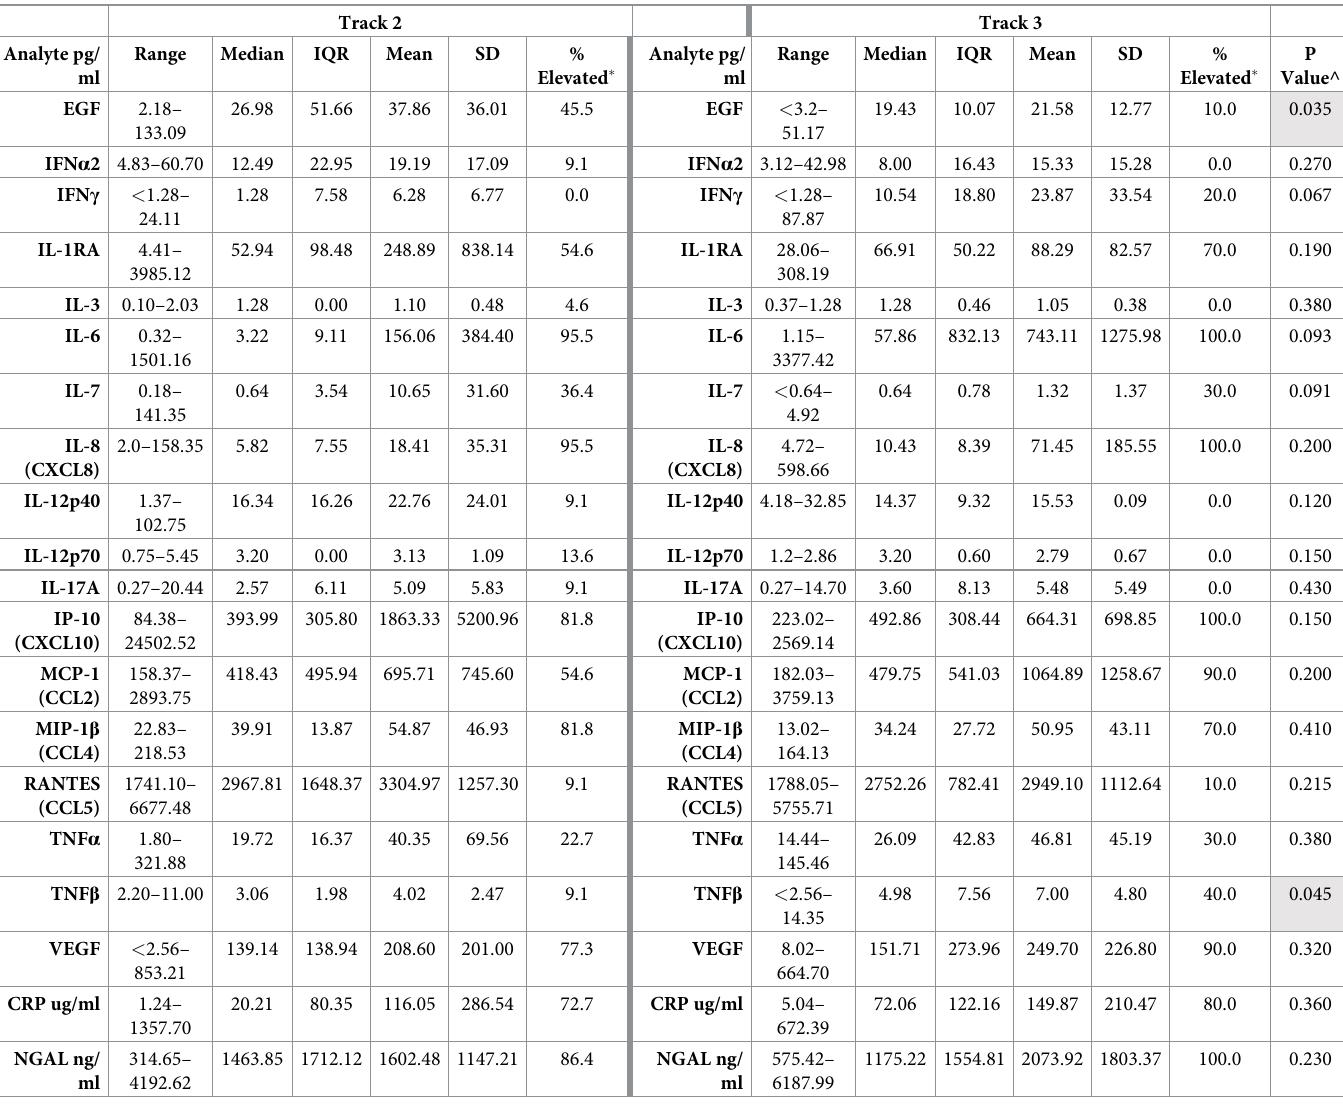
Table 6. Summary of Day 10 Recipient Cytokine Levels of